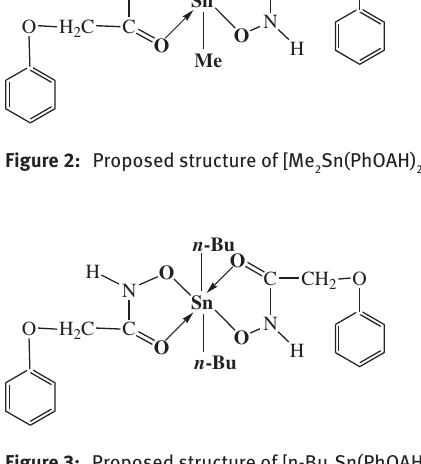
Figure 3: Proposed structure of [n-Bu